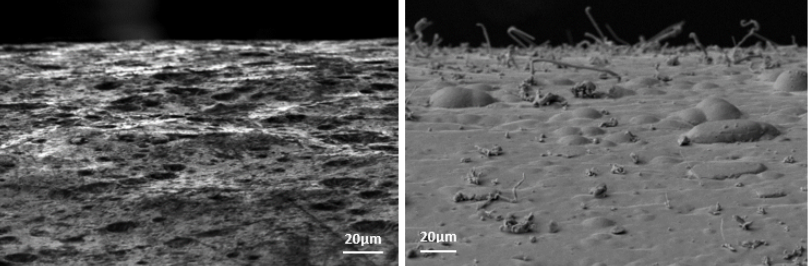
Figure 1. Differences in ZW growth in zinc coated surfaces after 10 months in service. It can be observed how white zinc alkaline coating ( left ) developed substantially more ZW than hot dip galvanized coating ( right ), where its presence is null.